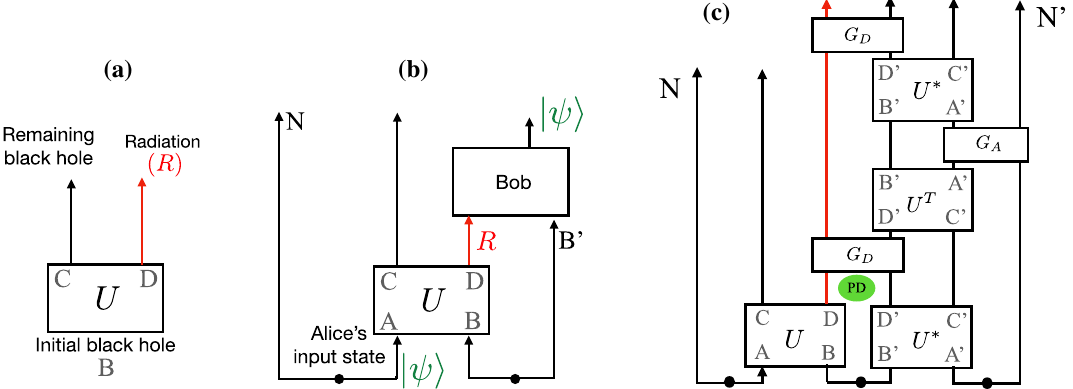
Fig. 7 Information recovery from a black hole. a In Page’s calcula- tions, an initial black hole B is evaporating radiation R with time. The growing size of the radiation should be compared to the forward time, here denoted with up arrow. Assuming the Haar random dynamics to model black hole, Page showed that to learn about the black hole from the radiation one has to wait for the black hole to evaporate half of its entropy, and this time is of the order ∼ M 3 , here M is black hole mass. b Hayden–Preskill protocol begins with a maximally entangled pair between BB’ (black hole B and old radiation B’). The initial input